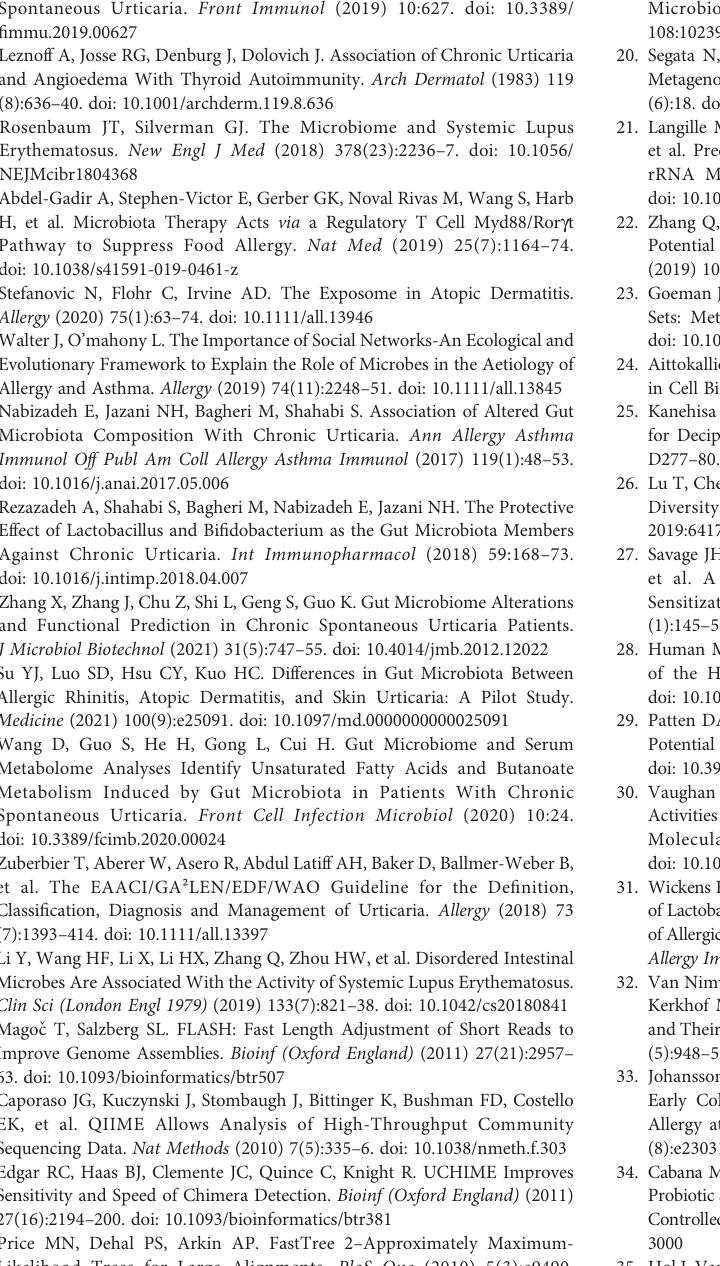
Supplementary Table 7 | Gut metabolomic pro fi les between patients with CSU and HCs. Supplementary Table 8 | Comparative functional differences of metabolites in patients with CSU and HCs. Supplementary Table 9 | Correlations between intestinal microbiota and the